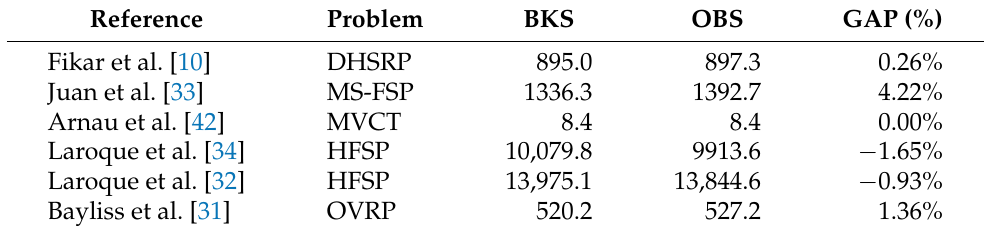
Table 2. Information on the selected problems.